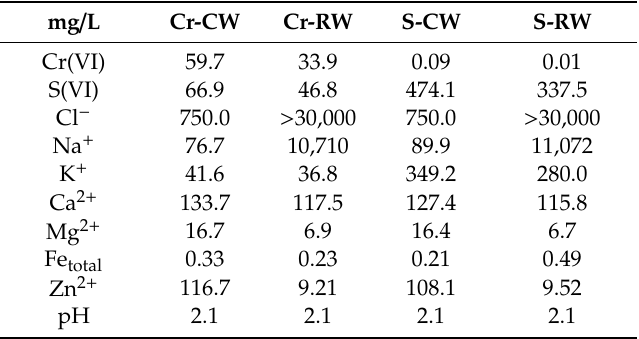
Table 1. Chemical composition and pH of Cr-CW, Cr-RW, S-CW and S-RW wastewaters. mg /